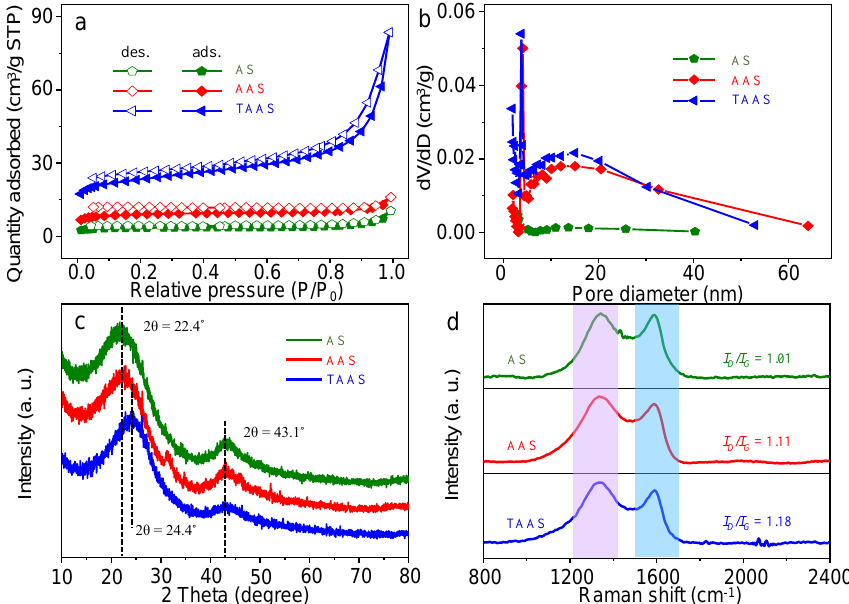
Figure 2. N 2 adsorption-desorption isotherms ( a ) and corresponding pore size distribution diagrams ( b ) of AS, AAS and TAAS. XRD patterns ( c ) and Raman spectra ( d ) of all catalysts. XRD patterns are used to characterize the crystal structures of AS, AAS and TAAS.